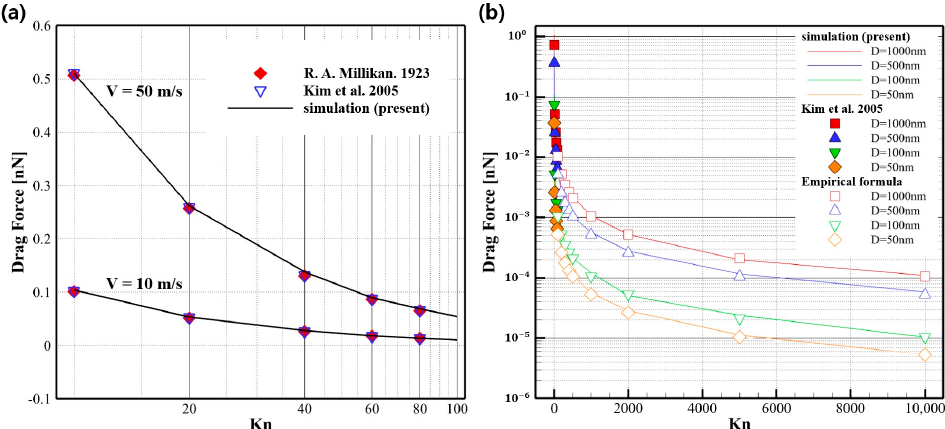
Figure 4. ( a ) Drag force for various values of 𝐾𝑛 at velocities of 10 m/s and 50 m/s [29,31]. ( b ) Drag force for various particle sizes [31].